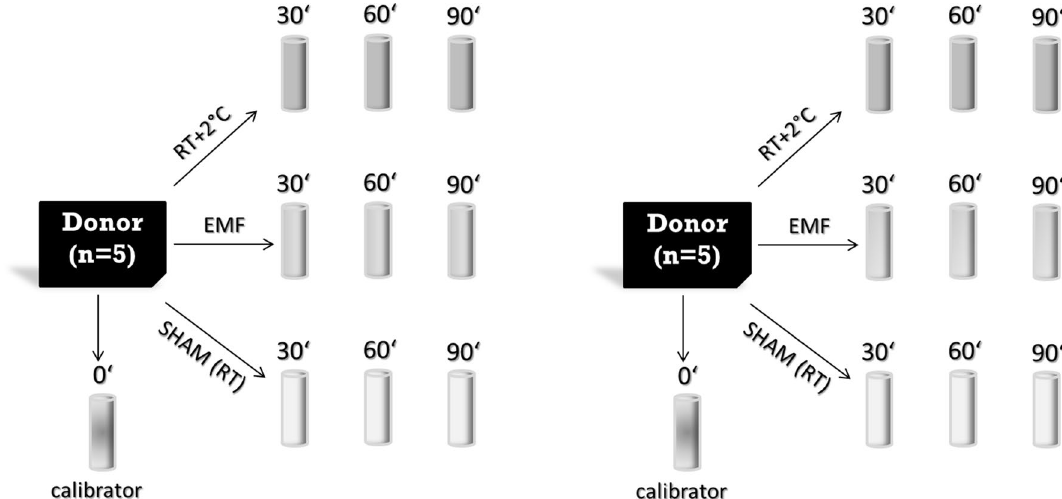
Figure 1. 10 EDTA tubes were drawn from each donor (n = 5) and divided in the 3 different exposure situations (SHAM, 900 MHz EMF and RT + 2 °C). Additionally, 1 sample from each donor with 0 min exposure was used as the calibrator sample. Since the EMF exposure occurs over time (30, 60 and 90 min) and gene expression changes already arise through cultivation, the controls (RT + 2° C and SHAM) must also be cultivated for 30,